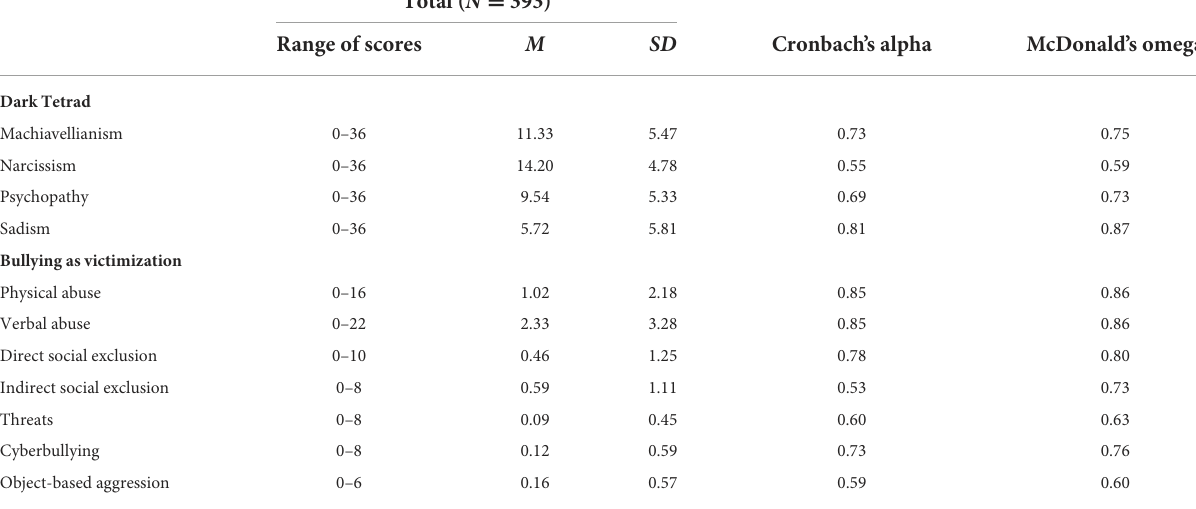
TABLE 1 Means and standard deviations for response